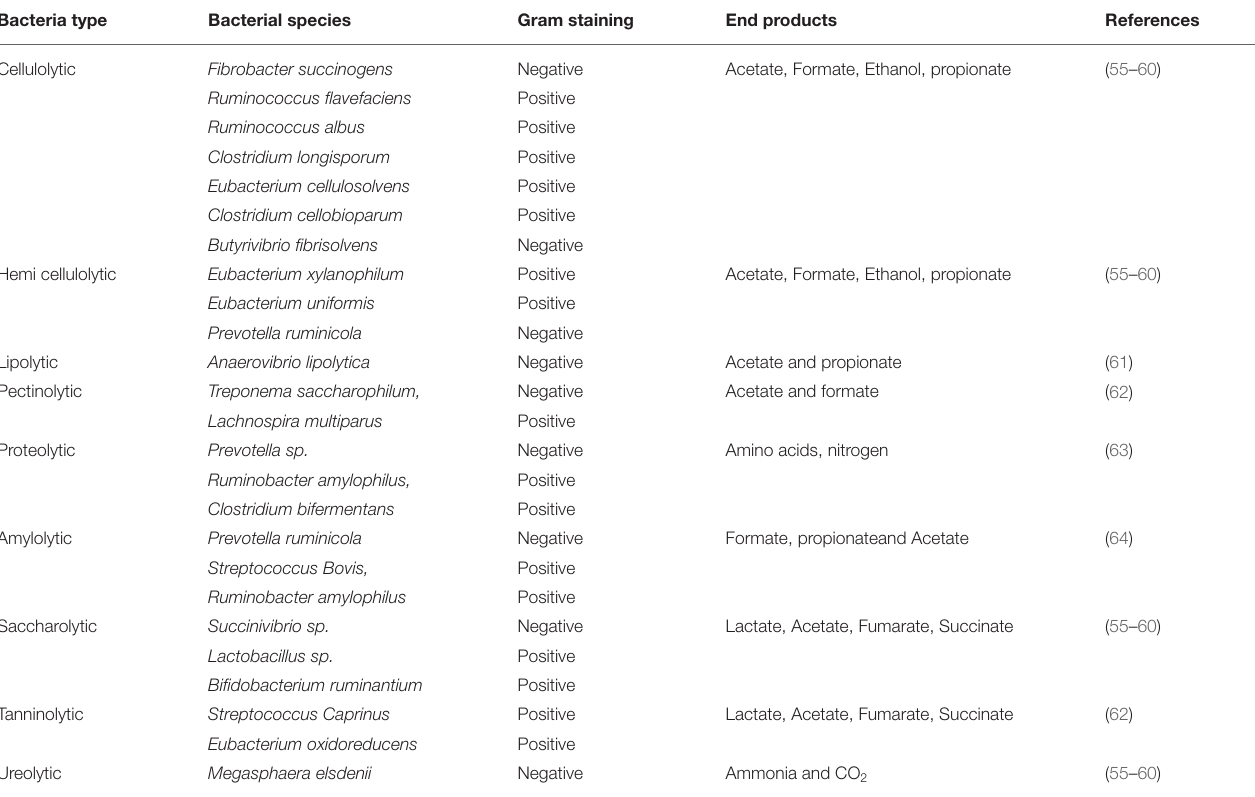
TABLE 2 | Gut bacteria in ruminants (mostly